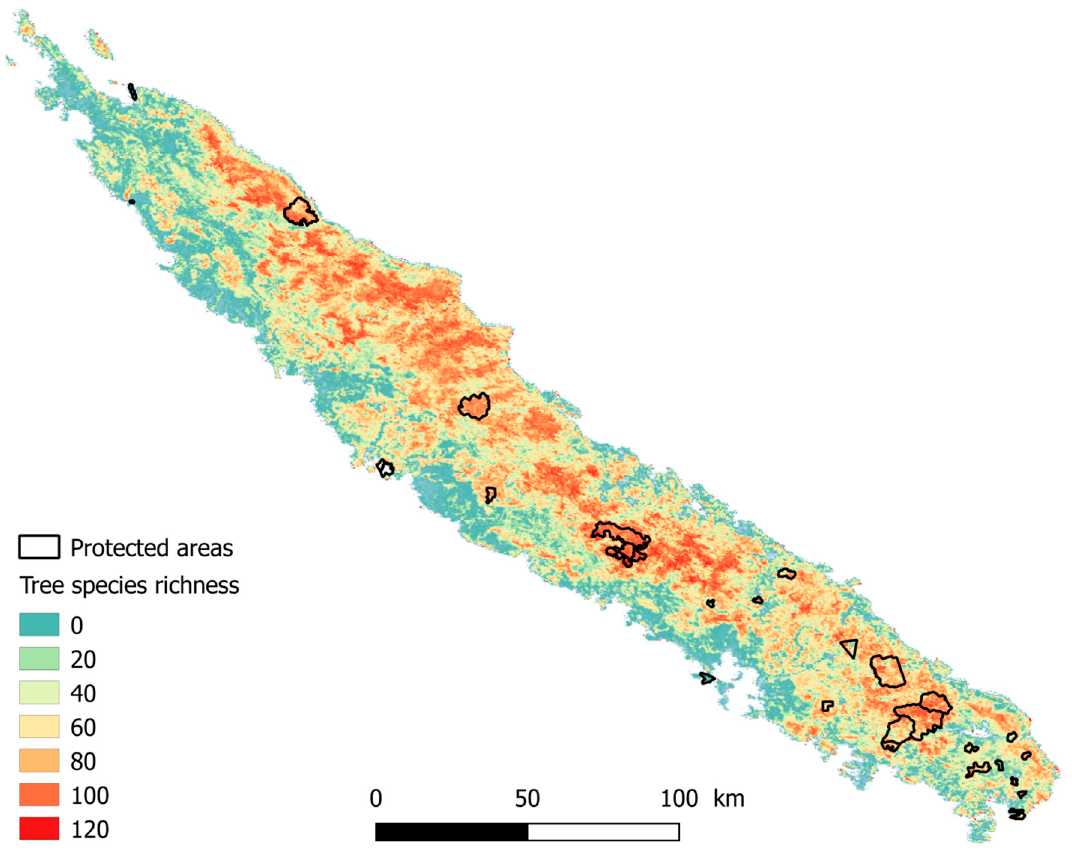
Figure 5. Species richness of trees with dbh ≥ 10 cm predicted from a single carefully selected scene (days 245 to 252 of 2004) and the protected area network in New Caledonia.